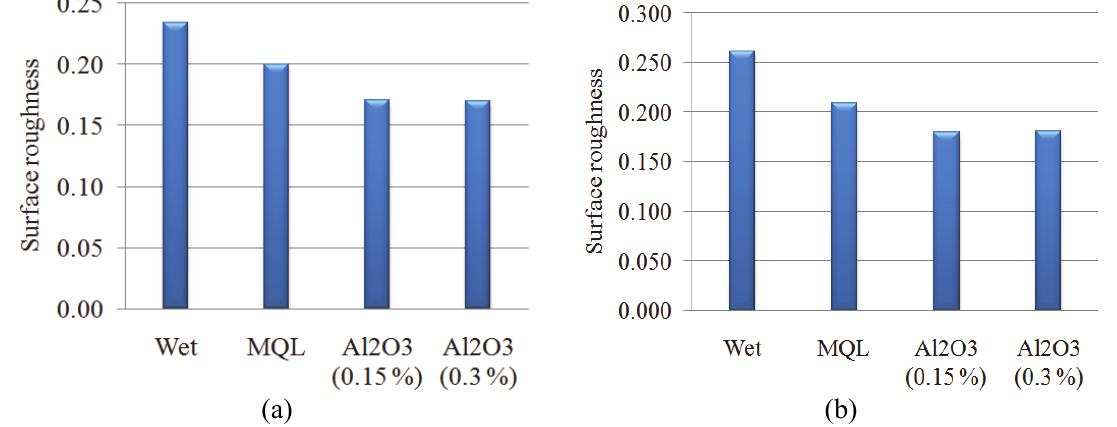
Fig. 2. Surface roughness under different cutting environments of (a) hard and (b) soft